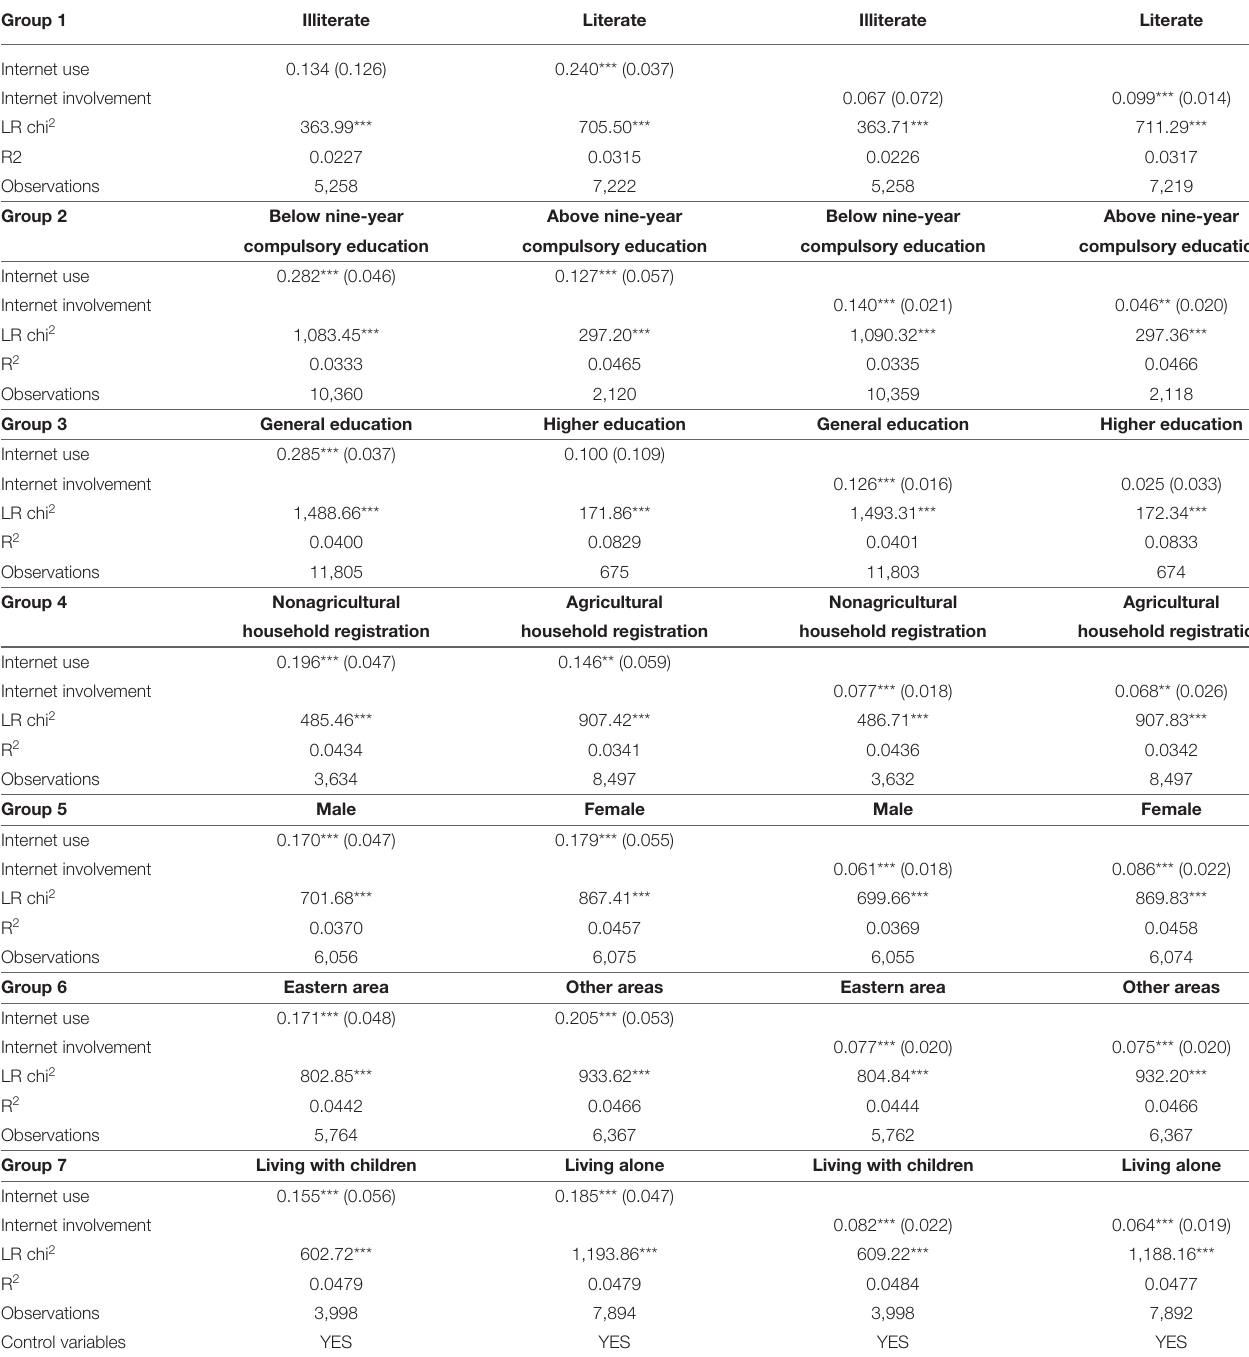
TABLE 4 | Results of heterogeneity